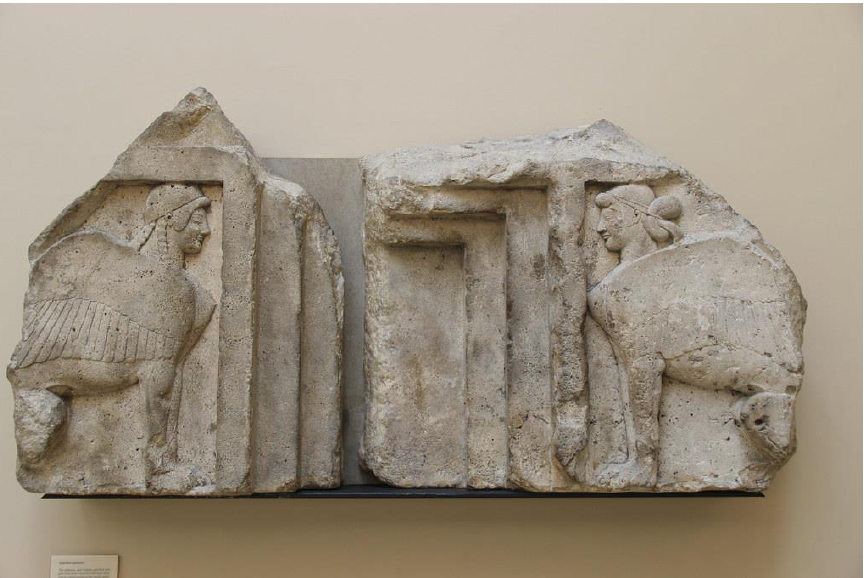
Figure 5. Winged Women with Architectural Details. (“Greek Marble Sculpture from Tomb of King Kybernis of Xanthos, 480 BC” by Gary Lee Todd, Ph.D. is licensed under CC PDM